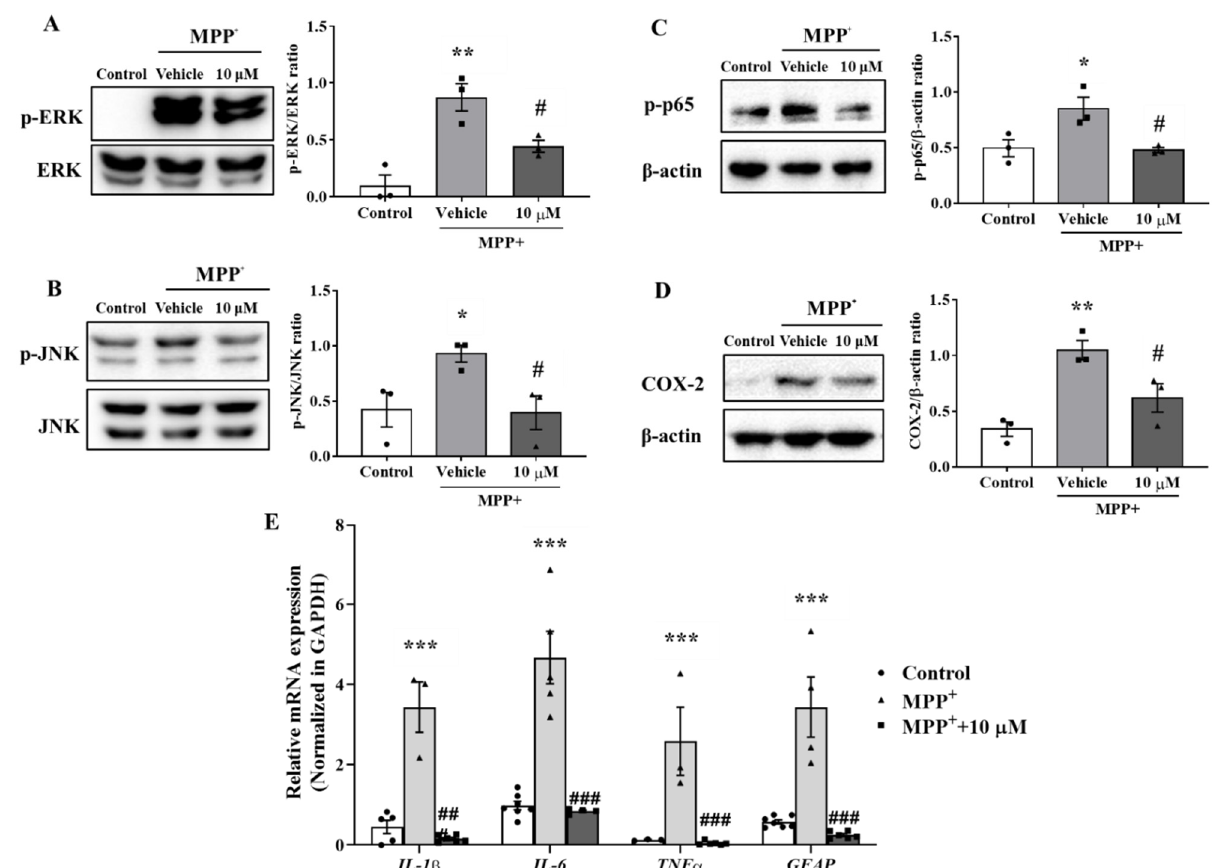
Figure 3. MHY2699 mediated astroglial activation through the MAPK-NF- κ B pathway. ( A , B ) Western blot analysis showed that MHY2699 repressed MPP + -induced ERK and JNK phosphorylation in primary astrocytes ( n = 3). ( C , D ) Western blot analysis showed that MPP + increased the phosphorylation of p65 and COX-2 and that these were decreased significantly by MHY2699, which demonstrated the anti-inflammatory effect of MHY2699-involved regulation of the MAPK-NF- κ B pathway. Three independent experiments were performed ( n = 3). ( E ) Real time-PCR showed that MHY2699 reduced MPP + -induced inflammatory cytokines level significantly. The values are reported as the means ± SEs ( n = 3–7). *** p < 0.001, ** p < 0.01, * p < 0.05 vs. naïve controls and ### p < 0.001, ## p < 0.01, # p < 0.05 vs. MPP + controls (analyzed by ANOVA with Tukey’s multiple comparisons).